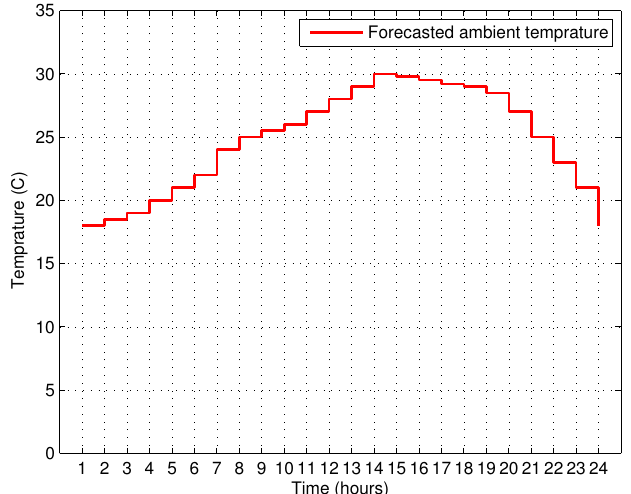
Figure 6. Day-ahead temperature